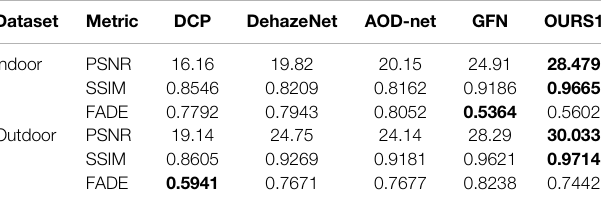
TABLE 2 | PSNR, SSIM, and FADE between the dehazing results and original images of synthetic image in SOATS. The best results are marked by bold.